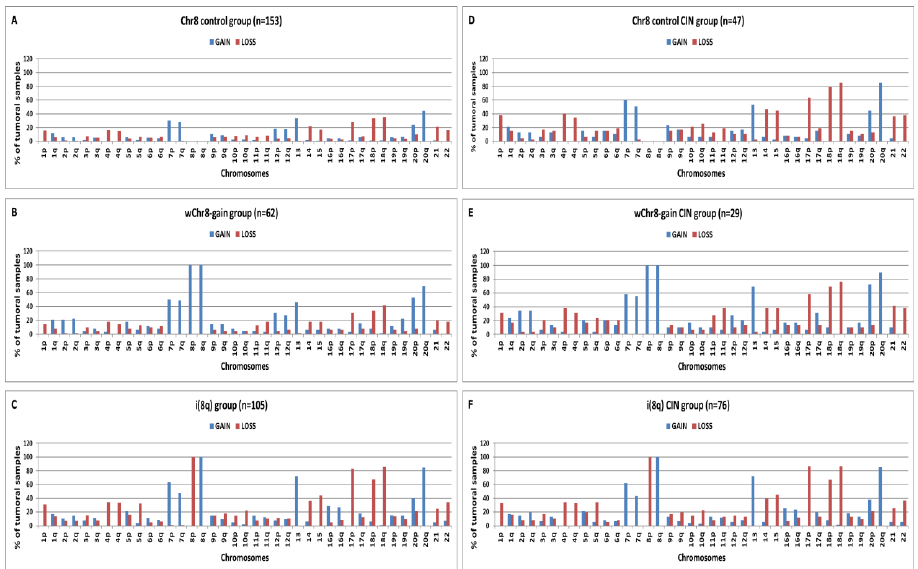
Figure 3. Arm-levels gains and losses in Chr8 control COAD group ( A , D ) and in wChr8-gain ( B , E ) and i(8q) ( C , F ) selected COAD groups. Results are expressed as a percentage of tumour samples bearing arm-level gains or losses in the p or q arm in all COAD samples ( A , B , C ) or in CIN COAD samples ( D , E , F ).